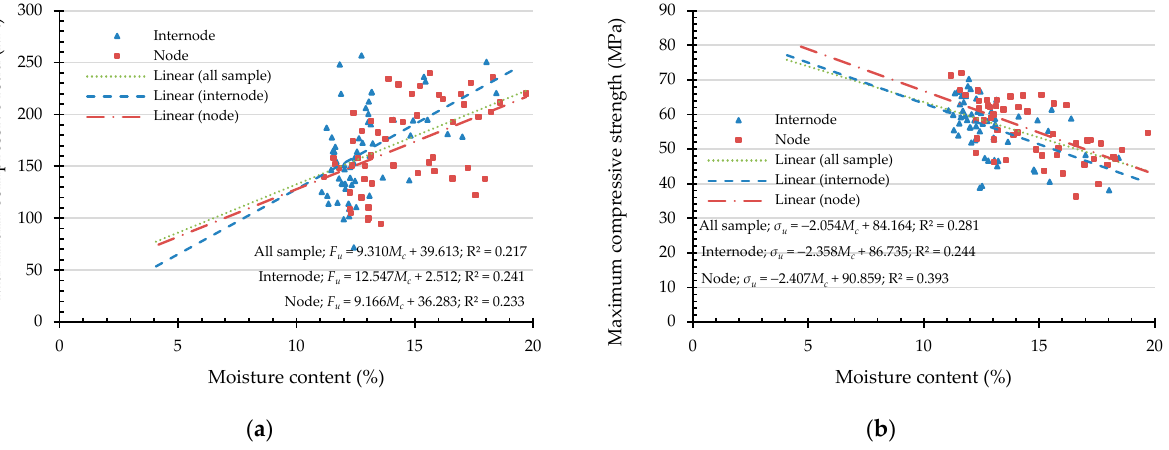
Figure 12. The simple linear regression analysis of bamboo bearing capacity with moisture content as an indicating property: ( a ) maximum compressive load ( F u ) and ( b ) maximum compressive strength ( σ u ).